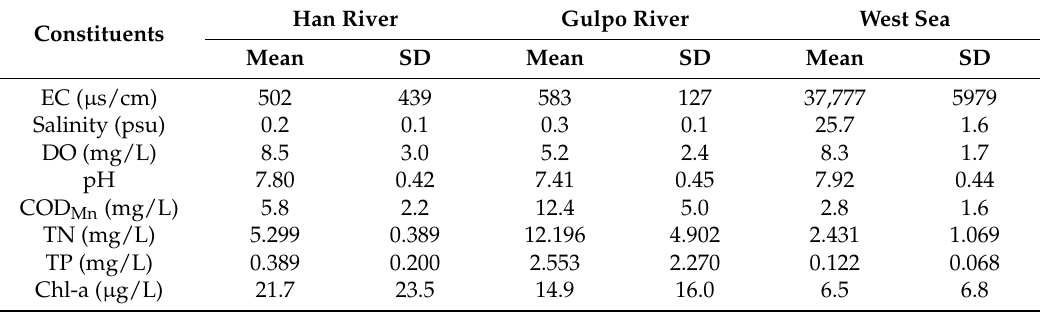
Table 2. Comparison of water quality parameters for the Han River, Gulpo River, and West Sea in 2014. Constituents